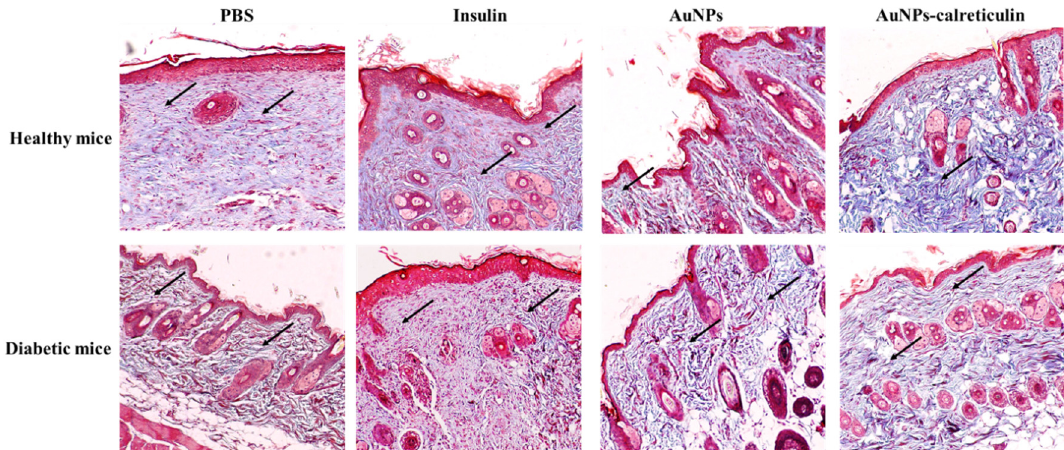
Figure 12. Masson’s trichome staining after a full thickness skin incision was performed. Skin tissue of healthy and diabetic mice at 15 days after surgery. Collagen deposits are observed in all treatments (black arrows), but a greater amount was observed in wounds treated with AuNPs–calreticulin (pictures magnification: 10×).